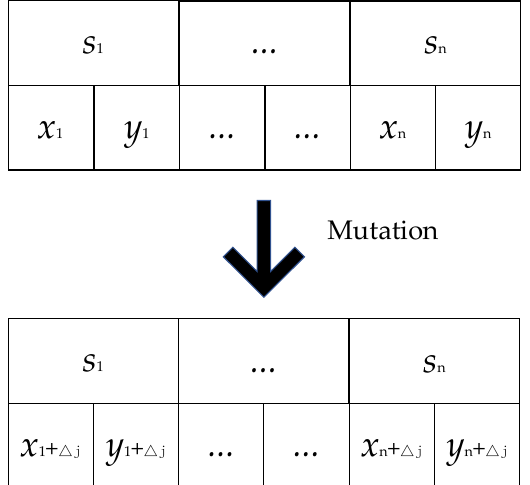
Figure 7. The process of population mutation.